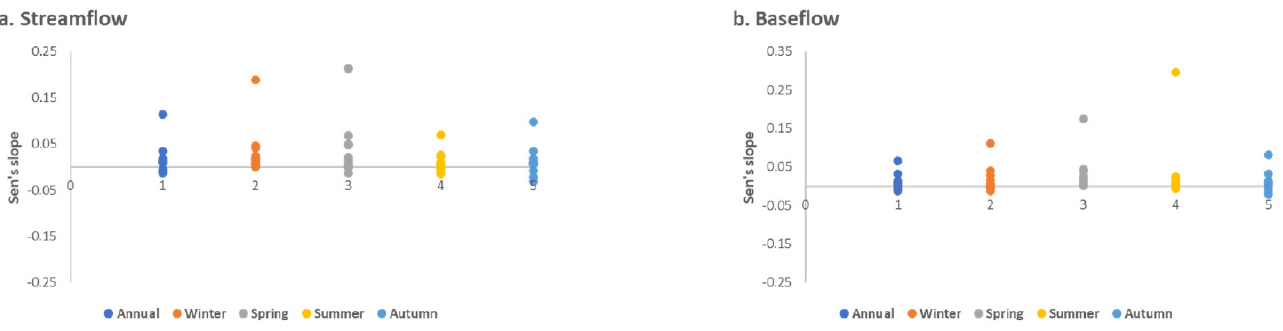
Figure 8. Sen’s slope summary of the ( a ) streamflow and ( b ) baseflow.